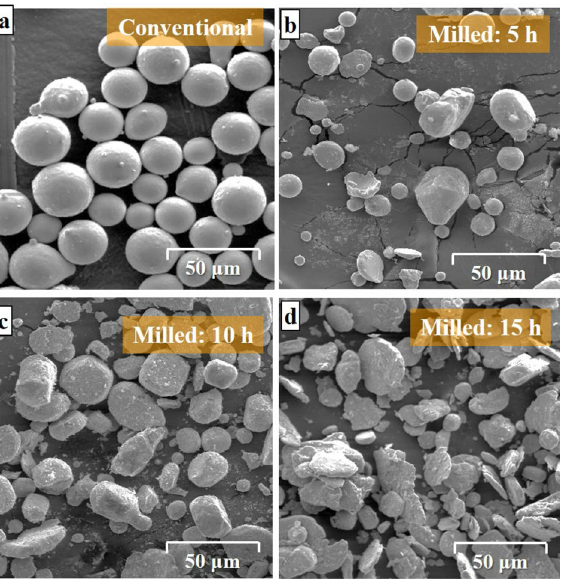
Figure 1. FESEM images of the morphology of the ( a ) commercial MCrAlY and as-milled MCrAlY powders after ( b ) 5 h, ( c ) 10 h and ( d ) 15